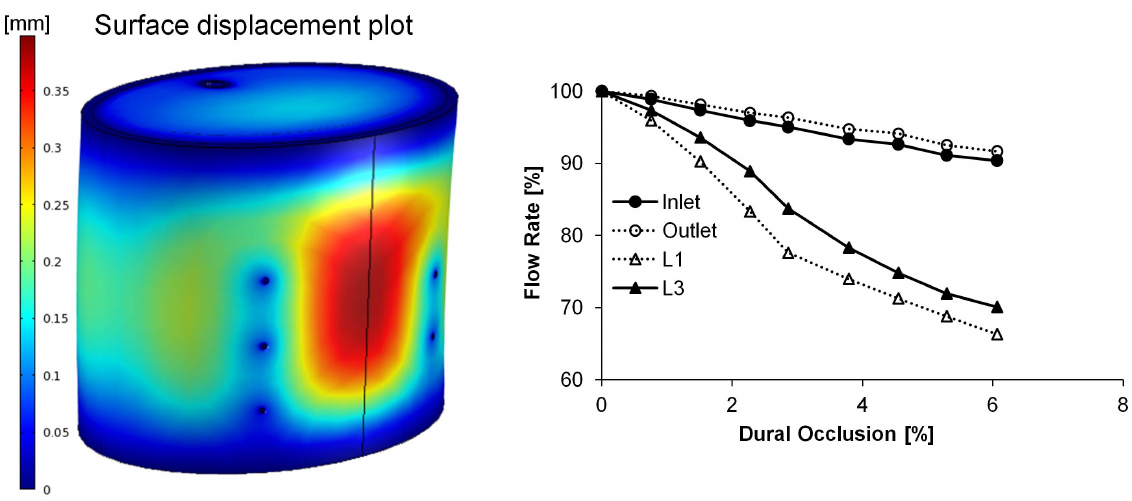
Figure 3. (Left) Representative surface plot of cervical spinal cord displacement under posterior loading. Colorimetric scale represents the induced displacement [mm]. (Right) Retained volumetric blood flow rate under posterior loading. The effect of posterior spinal compression on ASA and branch (L1 and L3) blood flow rates was assessed over the range of 0–6.05% dural occlusion, and the resultant change in arterial blood flow rates were calculated based on the percent of the baseline value (blood flow rate with no compressive